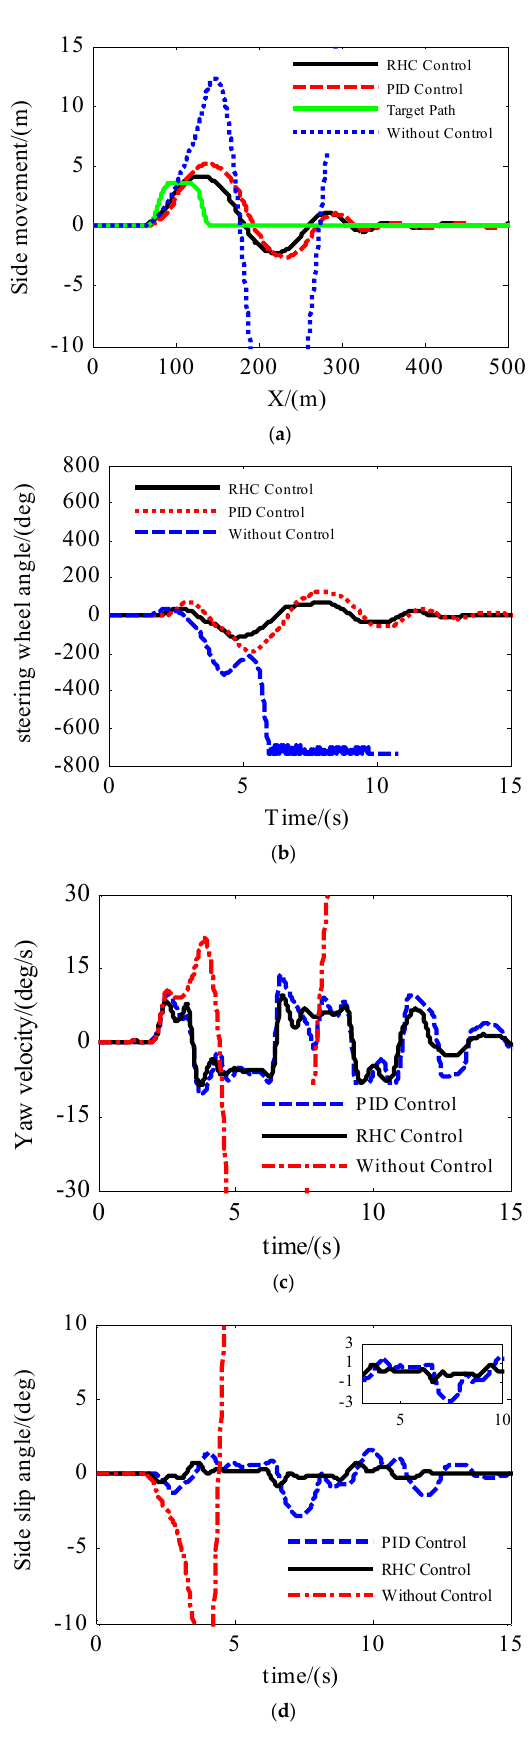
Figure 6. ( a ) Lateral displacement; ( b ) Steering wheel corner; ( c ) Yaw rate; ( d ) Sideslip angle.